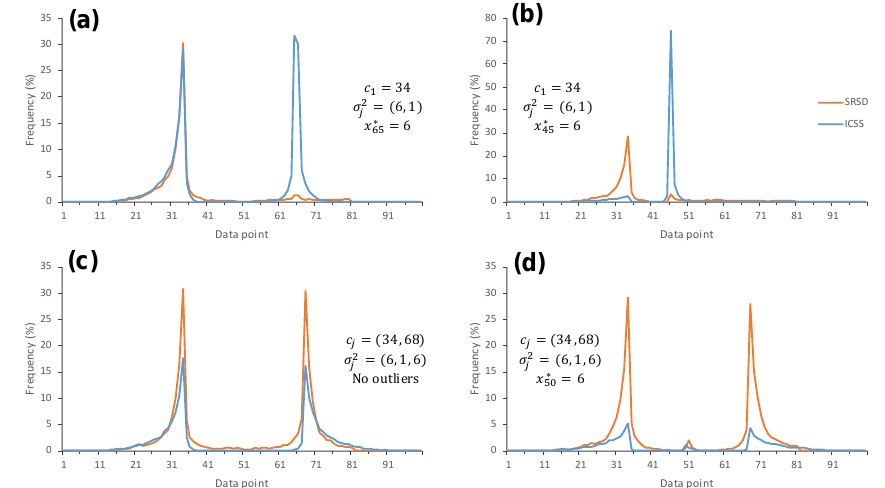
= 6. The parameters of SRSD used in each of the experiments are given in i